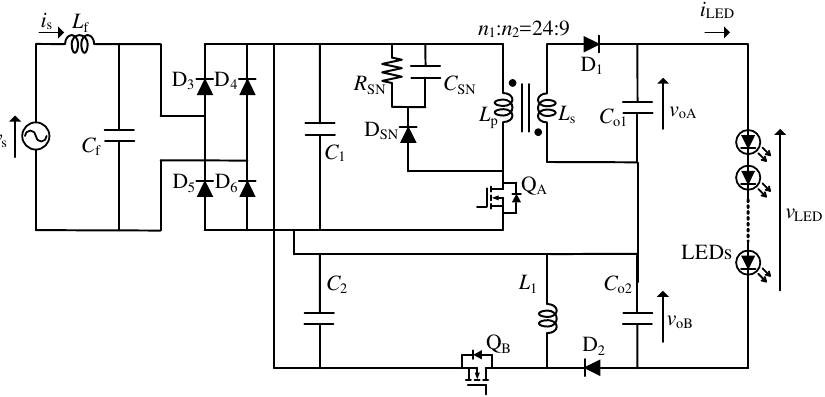
Figure 4. Power circuit diagram of the proposed LED driver.